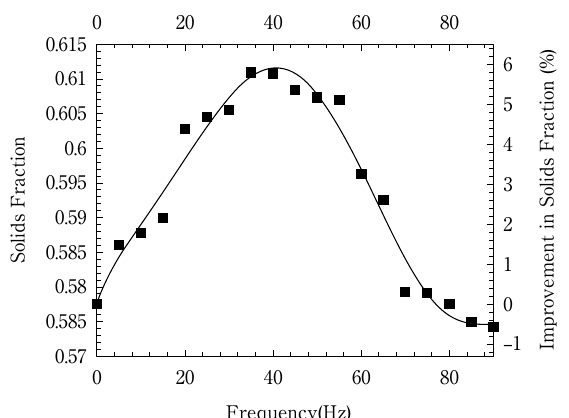
Fig. 8 Solids fraction behavior versus frequency at a/d = 0.24 and N = 600.